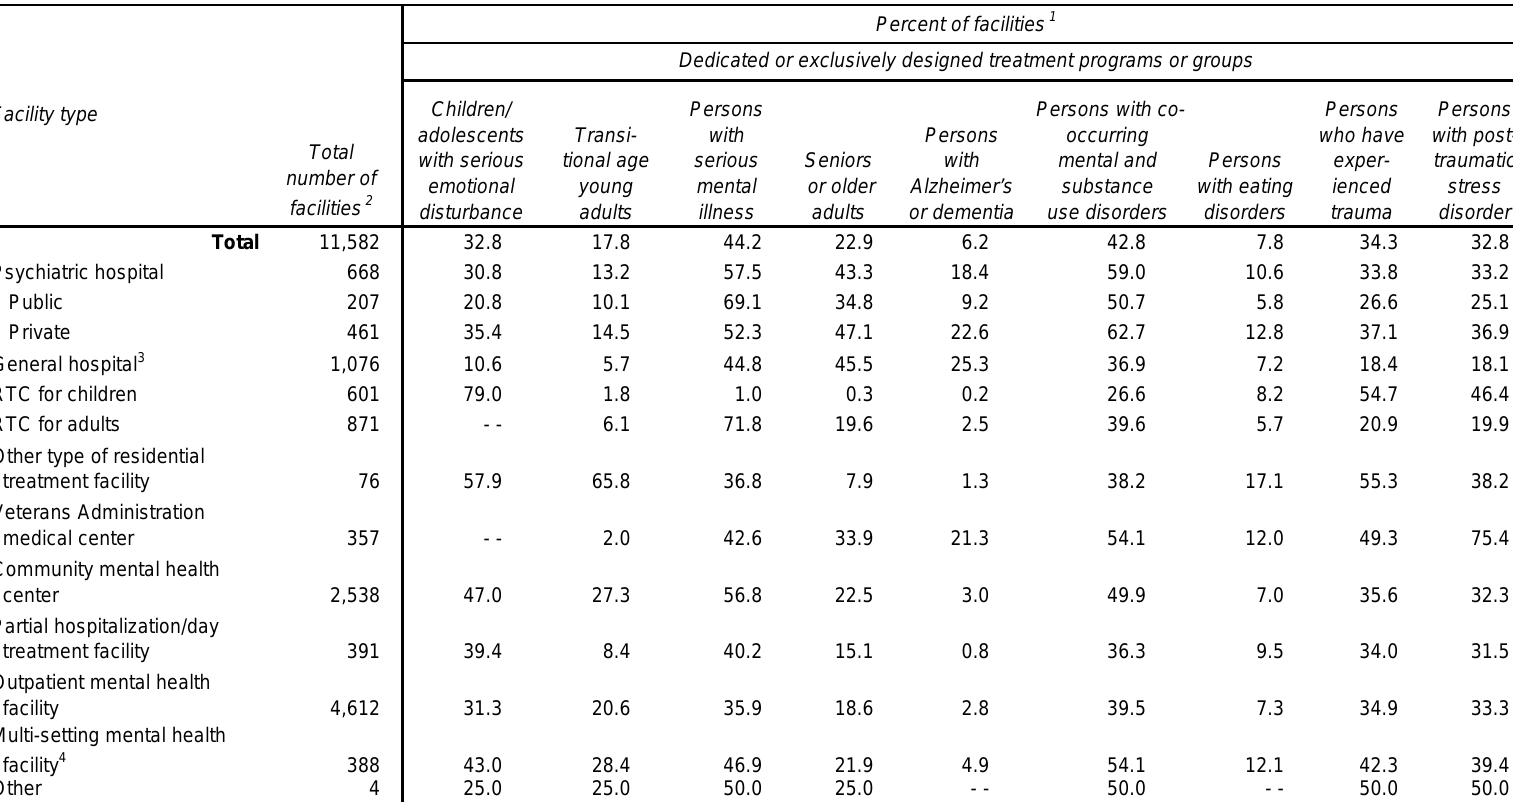
Table 2.6b. Mental health treatment facilities offering treatment programs or groups dedicated or exclusively designed for specific client categories, by facility type: Percent,